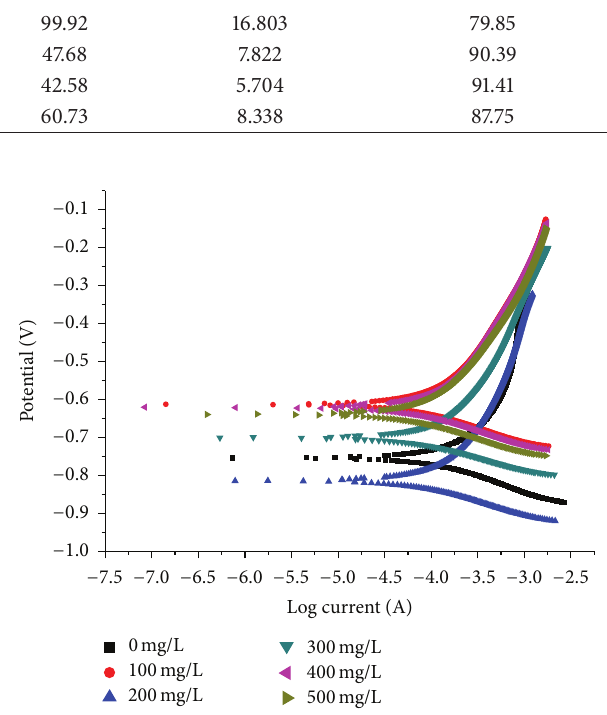
Figure 1: The representative Tafel polarization plots in the absence and presence of different concentration of Myrmecodia Pendans